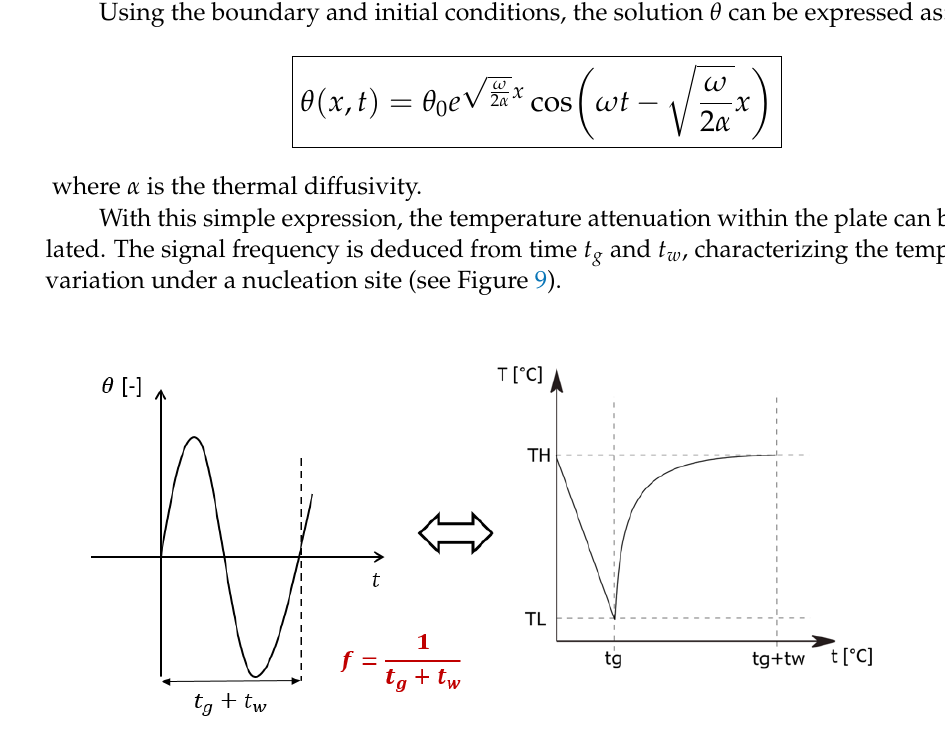
Figure 9. Correspondence between the harmonic variation and the temperature variation imposed in the initial